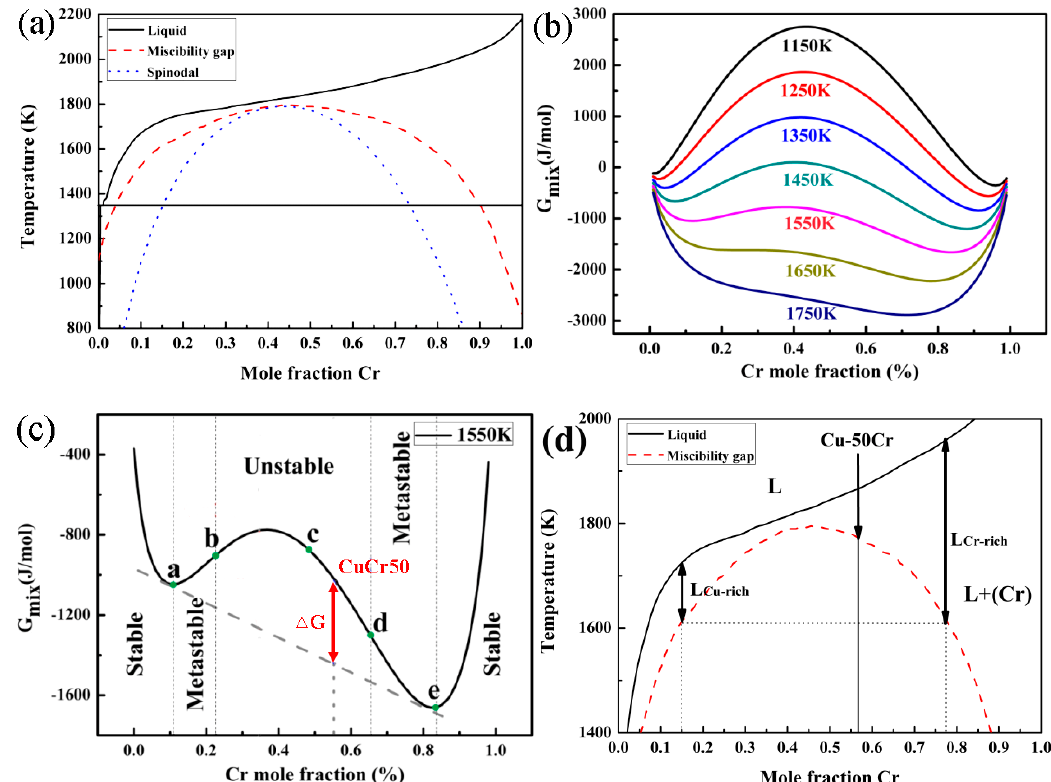
Figure 11. ( a ) Binary diagram of Cu-Cr alloy with a metastable gap predicted by thermodynamic, data from Reference [31], ( b ) calculated mole Gibbs free energy (G mix ) of Cu-Cr alloy at different temperatures, ( c ) relationship between G mix and the composition of Cu-Cr alloy, and ( d ) liquid phase separation under rapid cooling conditions.